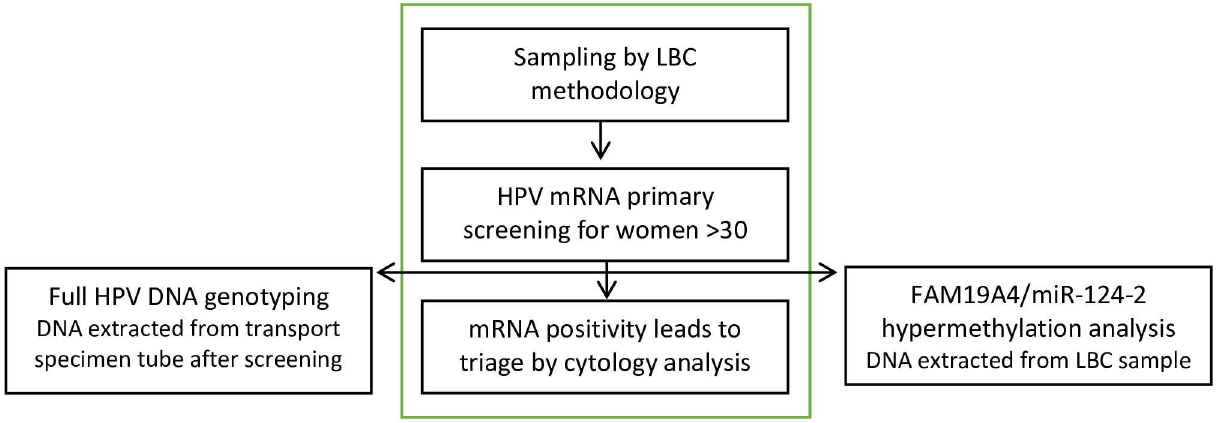
Fig 1. Study flowchart. The steps within the green middle box are part of the cervical cancer screening program in O¨rebro County, Sweden, where women 30 years and older are screened with primary HPV. All mRNA-positive results lead to reflex cytology analysis on the same sample with liquid- based cytology (LBC) method. For this study, all HPV mRNA–positive samples were subjected to full DNA genotyping (left) and methylation analysis of the host genes FAM19A4 and miR-124-2